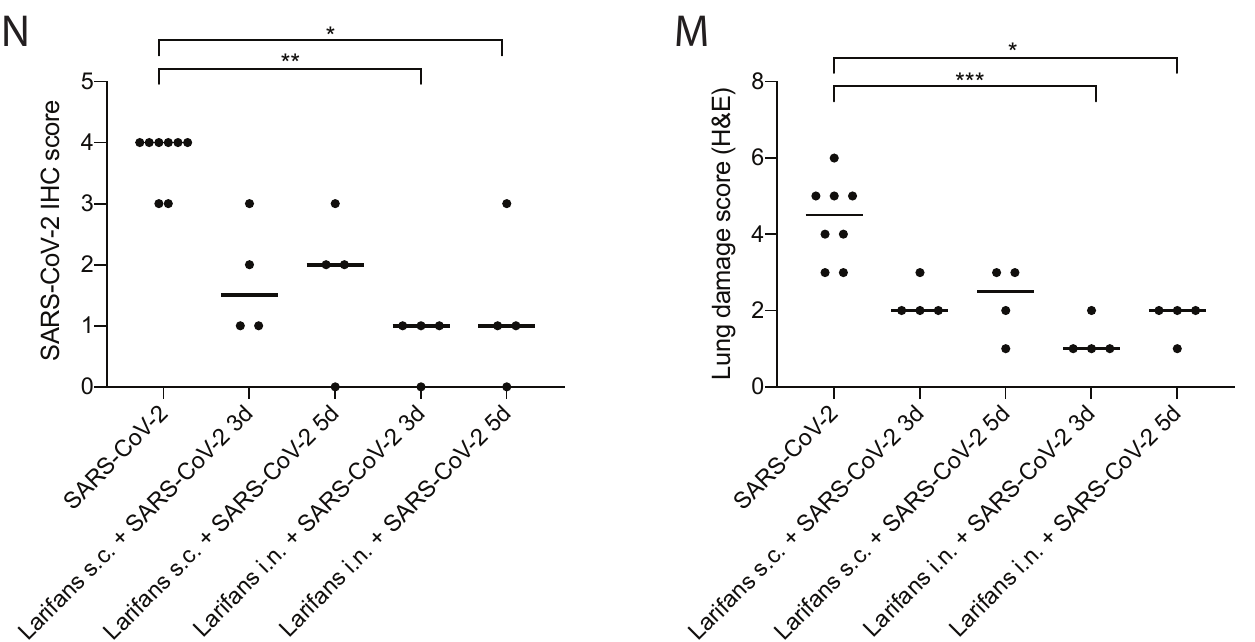
Figure 4. Larifan treatment reduces SARS-CoV-2 antigens in the lungs and improves lung histopatho- logical features of infected animals. Representative immunohistopathology for SARS-CoV-2 NP (green) ( A – F ) and hematoxylin- and eosin-stained ( G – L ) images of lungs of infected and infected Larifan-treated hamsters. ( A ) Lungs of infected untreated hamster three days post-infection; im- munoreactivity predominantly located in the bronchiolar epithelium. ( B ) Lungs of infected untreated hamster five days post-infection; immunoreactivity observed in different alveolar regions with patchy distribution pattern. ( C , D ) Lungs of infected and treated hamster three and five days after Larifan s.c. administration. ( E , F ) Lungs of infected and treated hamster three and five days after Larifan i.n. administration. ( G , H ) Lungs of infected untreated hamster three and five days post-infection: thickening of the interalveolar septa due to inflammatory infiltrate (blue arrow), vascular thrombosis (red arrow), alveolar septum fibrosis (black arrow), and signs of the bronchial epithelium hyper- plasia (yellow arrow). ( I , J ) Lungs of infected and treated hamster three and five days after Larifan s.c. administration. ( K , L ) Lungs of infected and treated hamster three and five after Larifan i.n. administration. ( M ) The score of immunolabeled virus NP in lungs of infected untreated and infected Larifan-treated hamsters. ( N ) Histopathological damage severity score of hamster lungs of infected untreated and infected Larifan-treated animals. Data presented as mean. Statistical significance analysis was performed using Kruskal–Wallis tests with Dunn’s multiple comparison test. * p < 0.05, ** p < 0.01, *** p < 0.001. Dots represent individual hamsters. Scale bars 100 µ